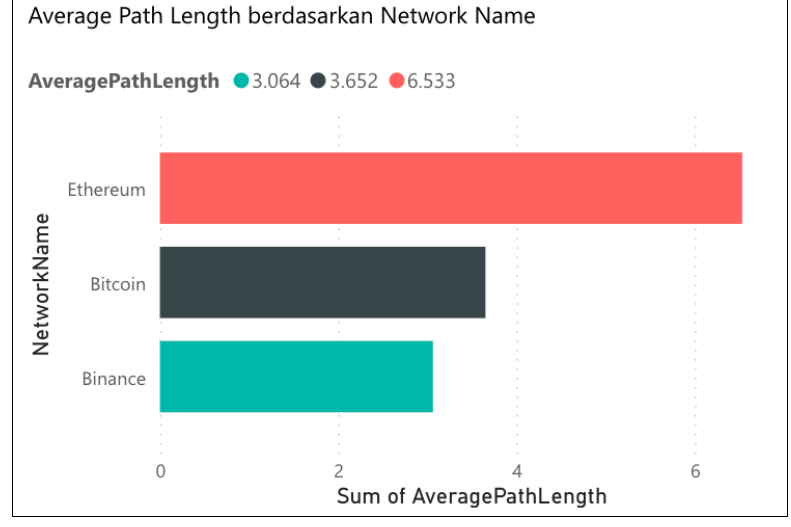
Figure 5(b). Average Path Length according to Cryptocurrency Name